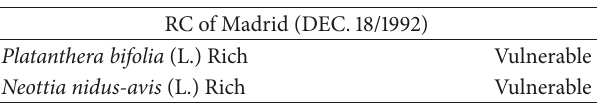
Table 18: Species included in the regional catalogue (RC) of Madrid (DEC. 18/1992).